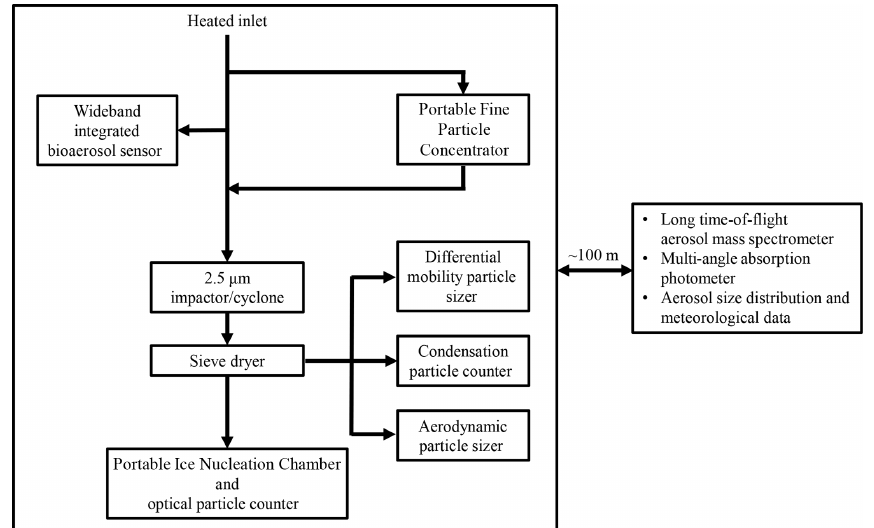
Figure 1. Instrumental